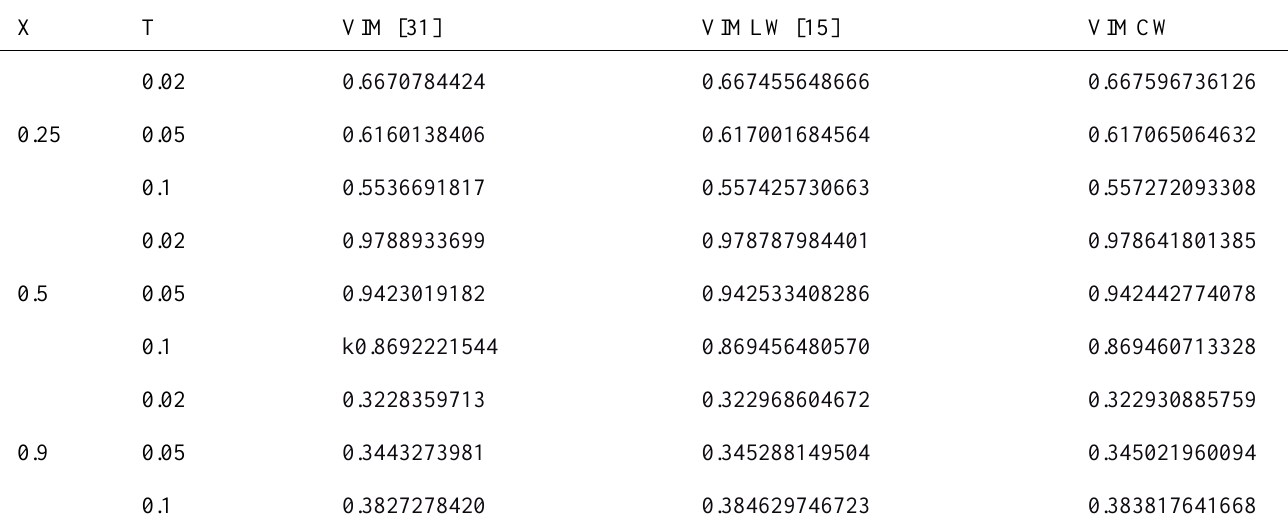
Analysis of the computed solution with different parameters, when 𝛼 = 𝛽 = 1, 𝛾 = 0.01 and 𝜀 = 0.1